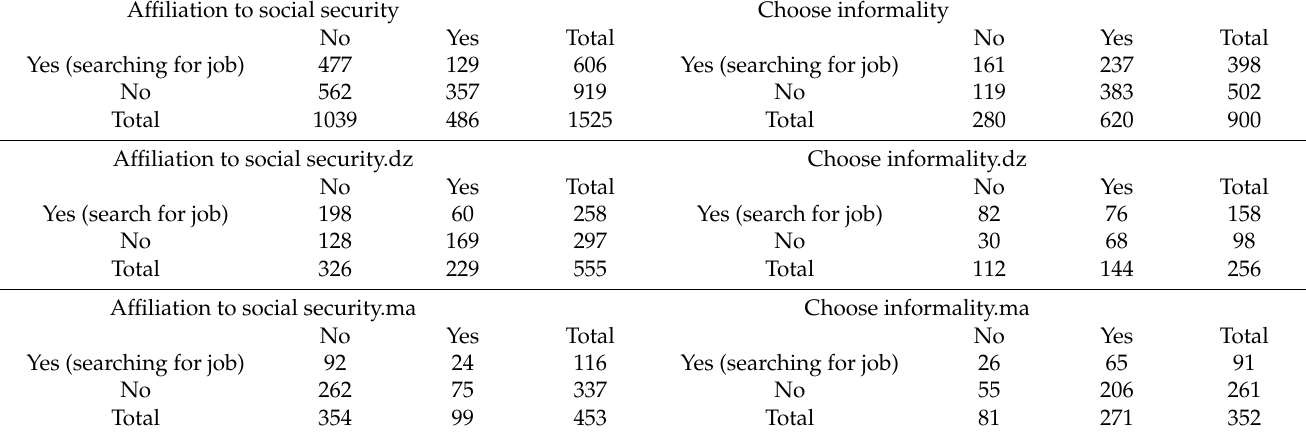
Table A6. Affiliation to social security and the reason for not being insured among new job seekers. Source: Sahwa